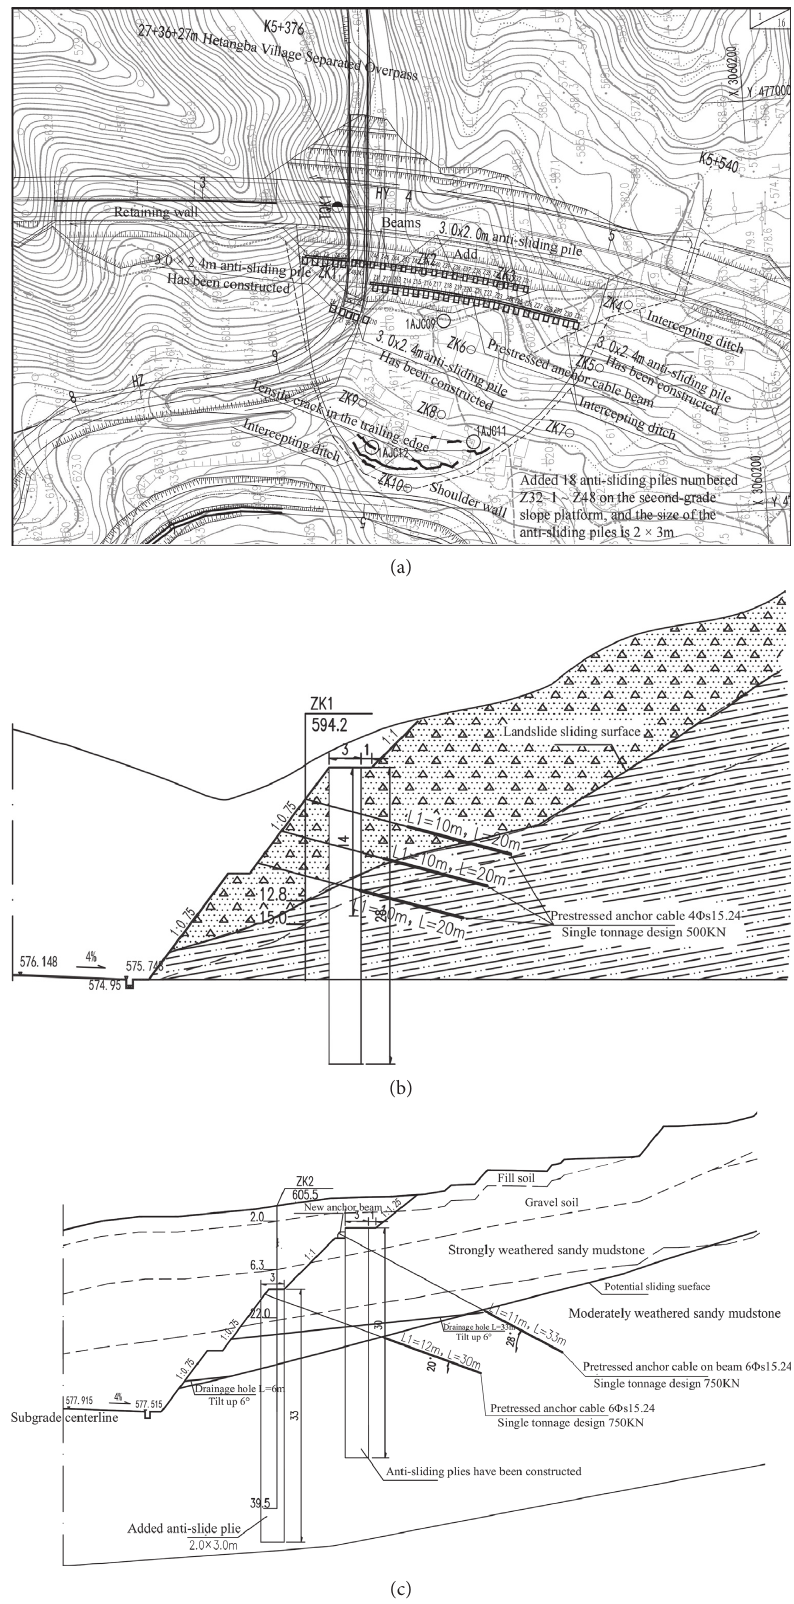
Figure 1: Slope strata and supporting measures with dual structure in the study area. (a) Overall plan of the slope (2016). (b) Cross-sectional view of the slope at K5 +365 (2014). (c) Cross-sectional view of the slope at K5 +420